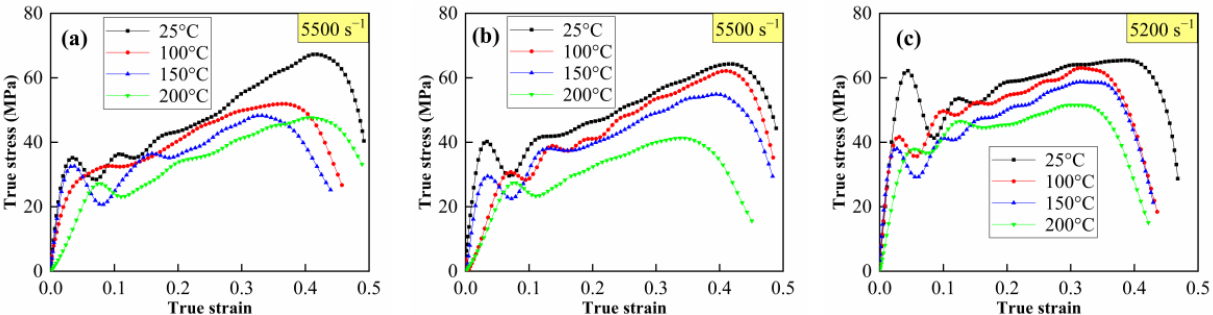
Figure 11. True stress–strain curves of Al-PTFE-W materials at elevated strain rates at 25 °C. ( a ) M20, ( b ) M50 and ( c ) M80.